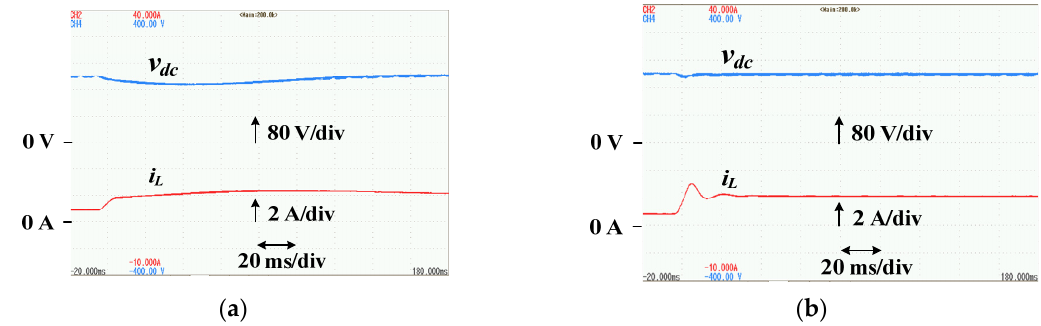
Figure 18. Load variation (200 W to 500 W). ( a ) PI control; ( b ) LQR.